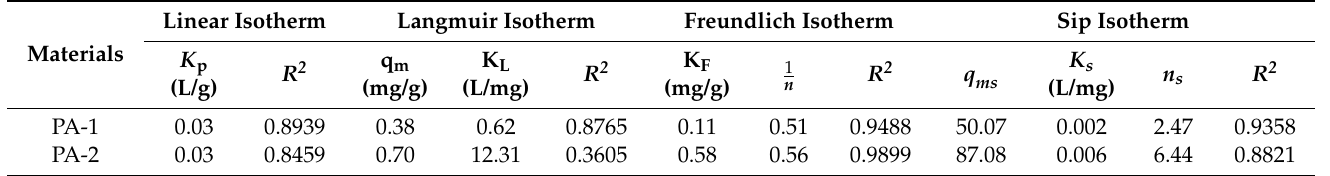
Table 5. Isotherm parameters of fluoride adsorption on PA-1 and PA-2